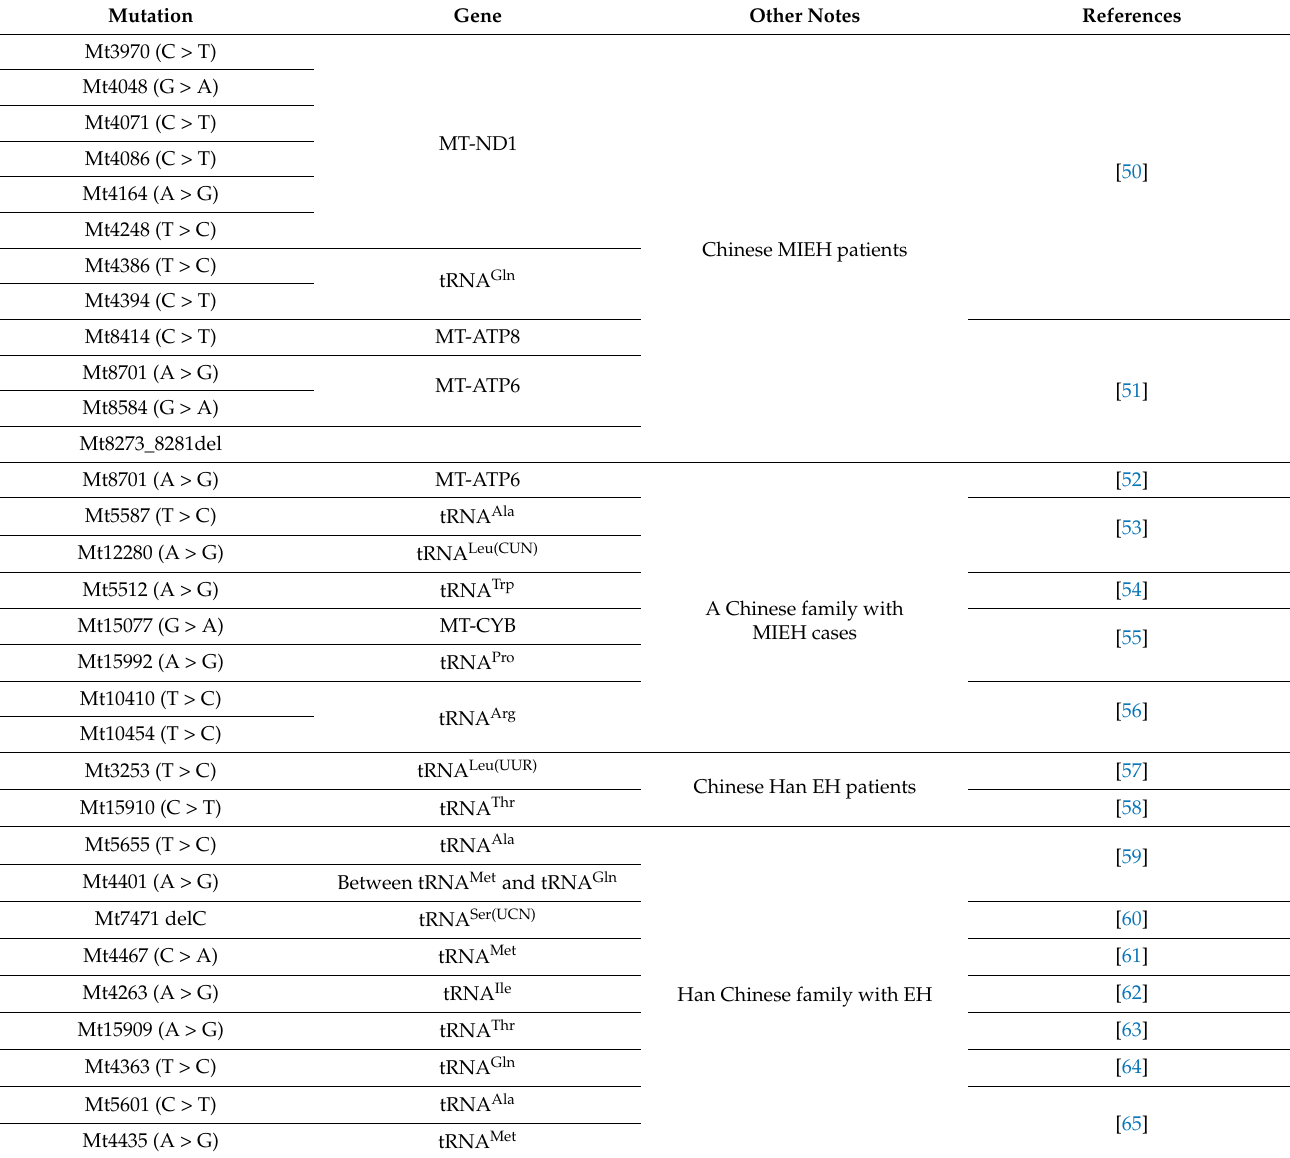
Table 2. List of mtDNA mutations associated with